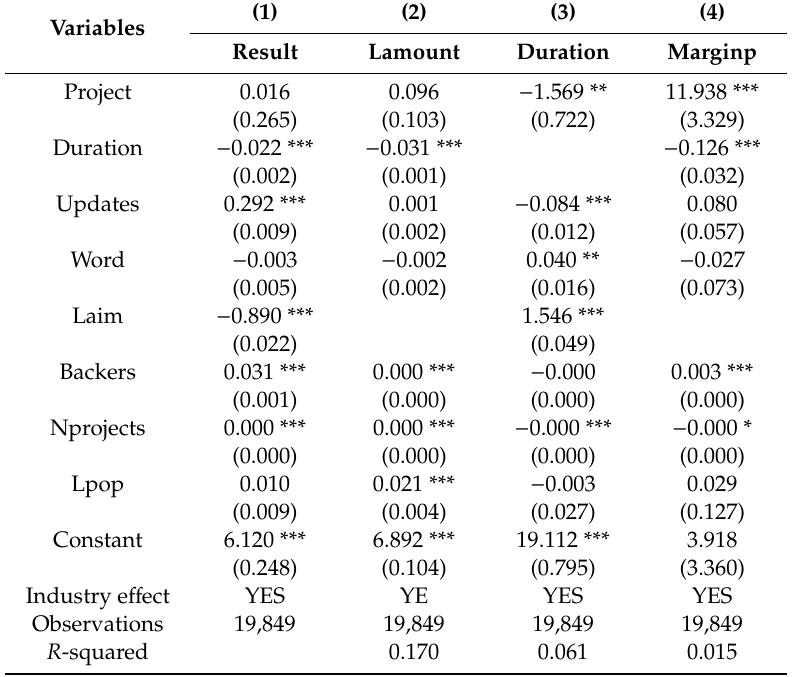
Table 11. U.S. Project. This table reports results of regression analysis of the success, amount raised, duration, and margin (%) variables when a U.S initiator starts a specific project. We controlled for di ff erent variables. Table 3 defines all the